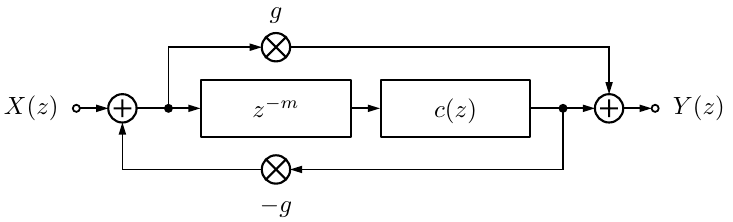
Figure 3. Dahl and Jot’s allpass filter with an additional lowpass filter c ( z )